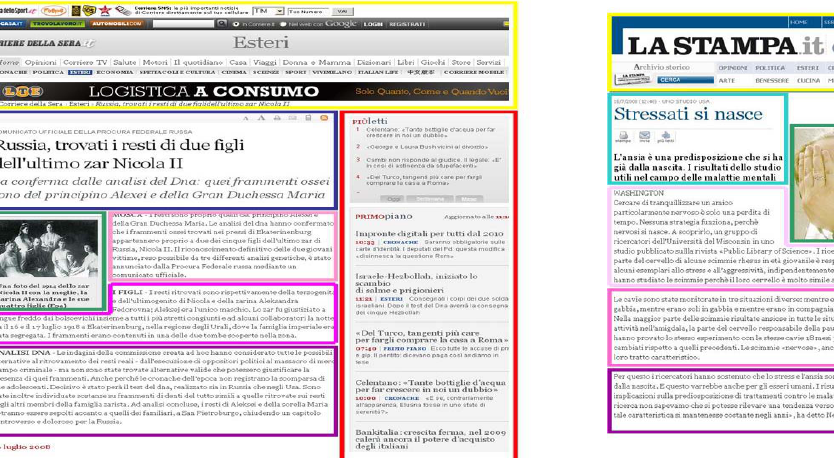
Figure 4 - Areas of Interest on CS2 story